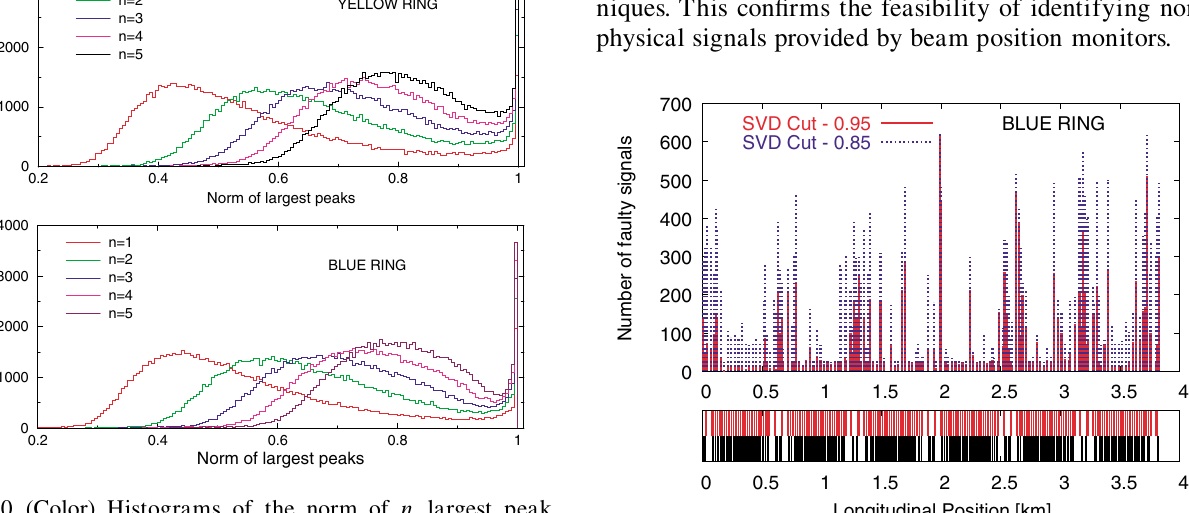
FIG. 10. (Color) Histograms of the norm of n largest peak values in each mode in the horizontal plane. Gaussian-like distributions represent coherent signal from good BPMs and peaks at 1 represent faulty BPMs.